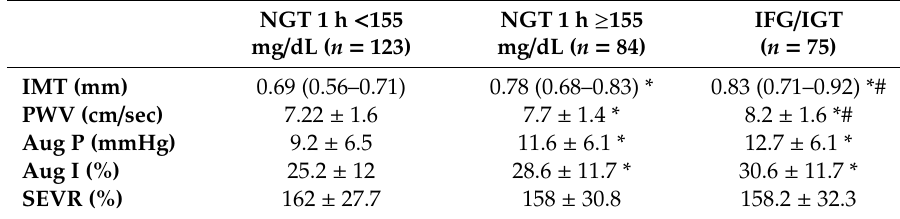
Table 2. Early markers of cardiovascular damage according to 1 h postload plasma glucose and glucose